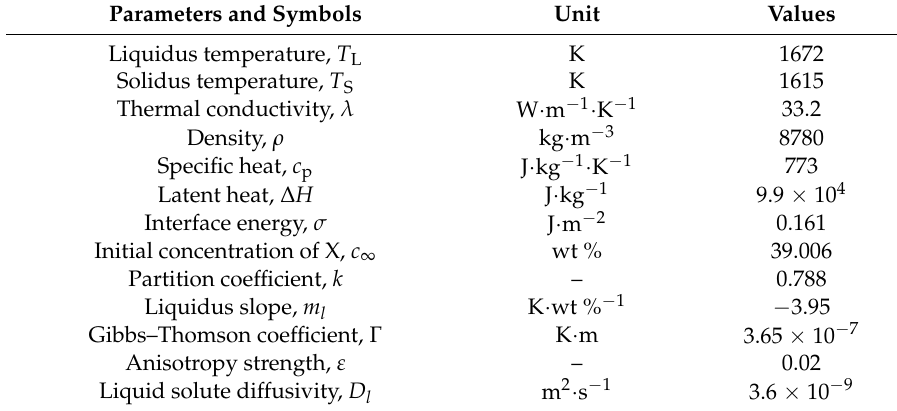
Table 1. Physical and thermodynamic parameters of the pseudo-binary Ni–X superalloy [21,22].